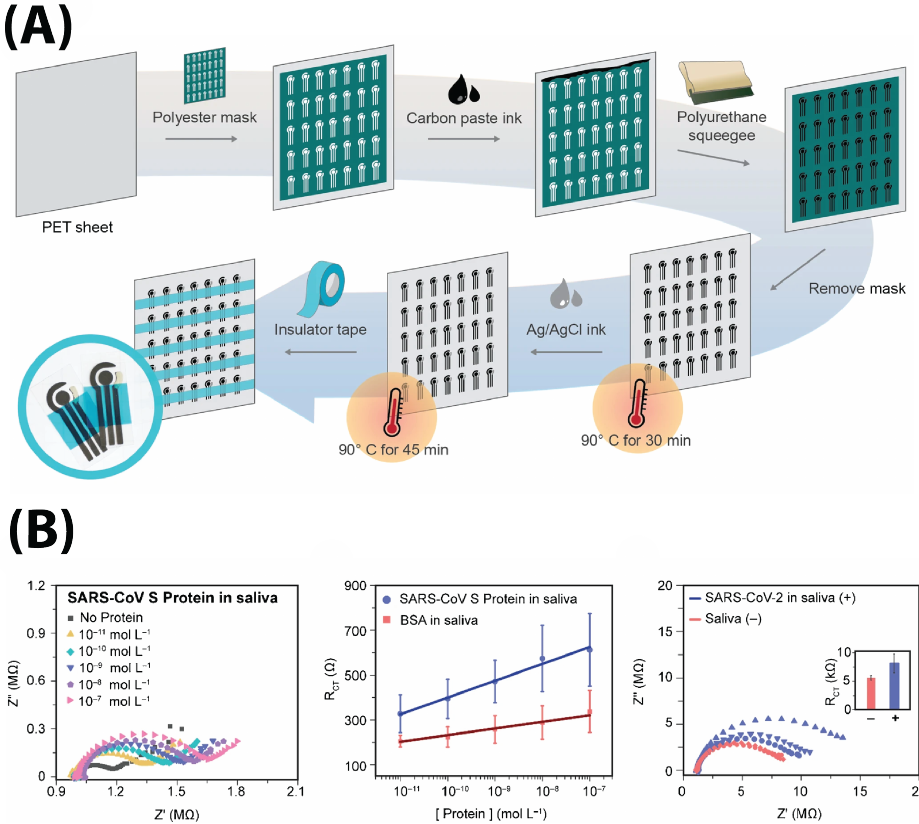
Figure 9. ( A ) The screen-printing fabrication process of Brazaca et al. for their carbon–carbon– Ag/AgCl electrodes [9] ( B ) The sensor response demonstrates increasing impedance parameters with increasing analyte concentration. Reprinted with permission from Springer Nature under the Creative Commons BY-SA 4.0